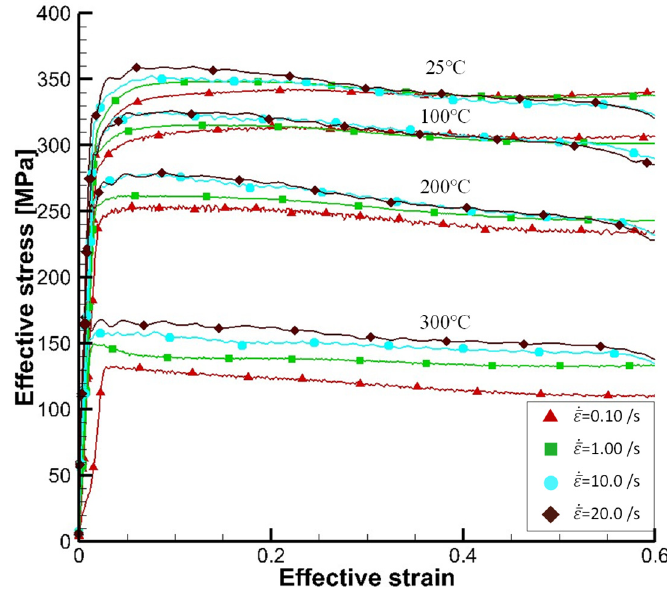
Figure 11. Effective strain-flow stress curves [106].